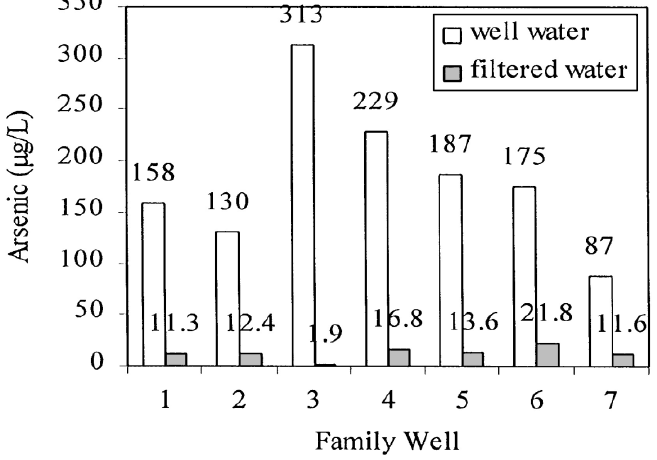
Figure 5. Comparison of arsenic concentrations in well water and the average arsenic concentration in the filtrate (after